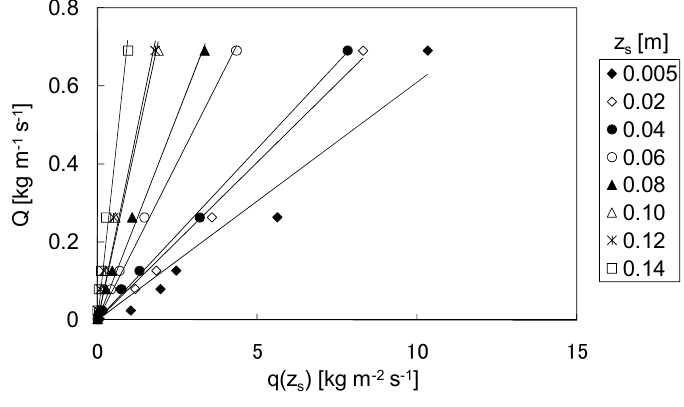
Figure 2. Relationship between the sand flux at z = 0.25 × 10 –3 m. d 50